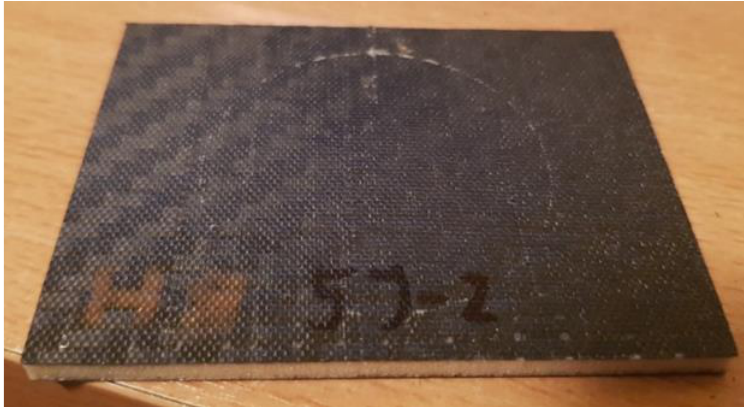
Figure 10. Herex 55 core specimen with face cracking on the side opposite to the impact.